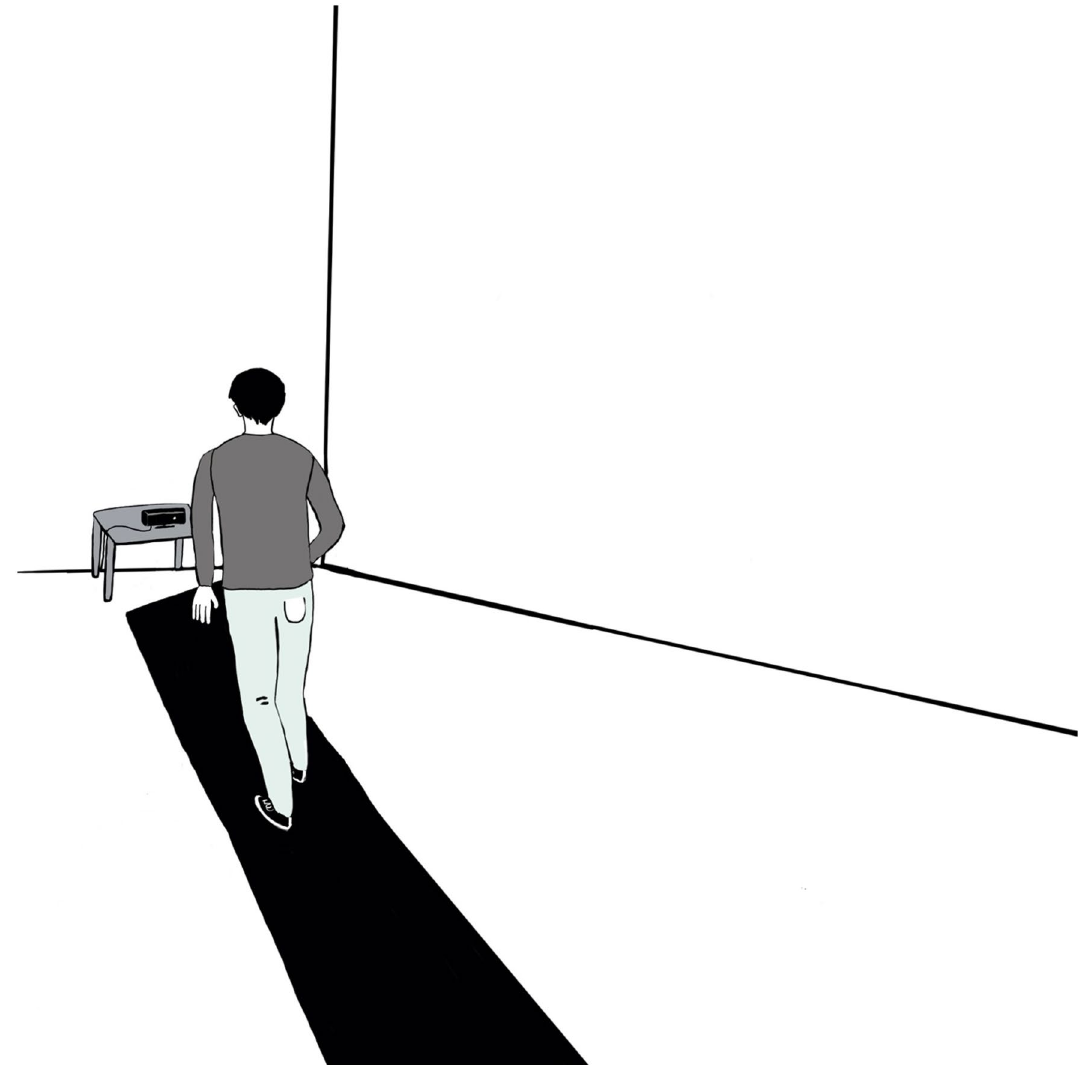
Figure 2. Illustration of the scene when participants walked toward the Kinect camera. Illustration from Leonore Blume (https:// noblu.